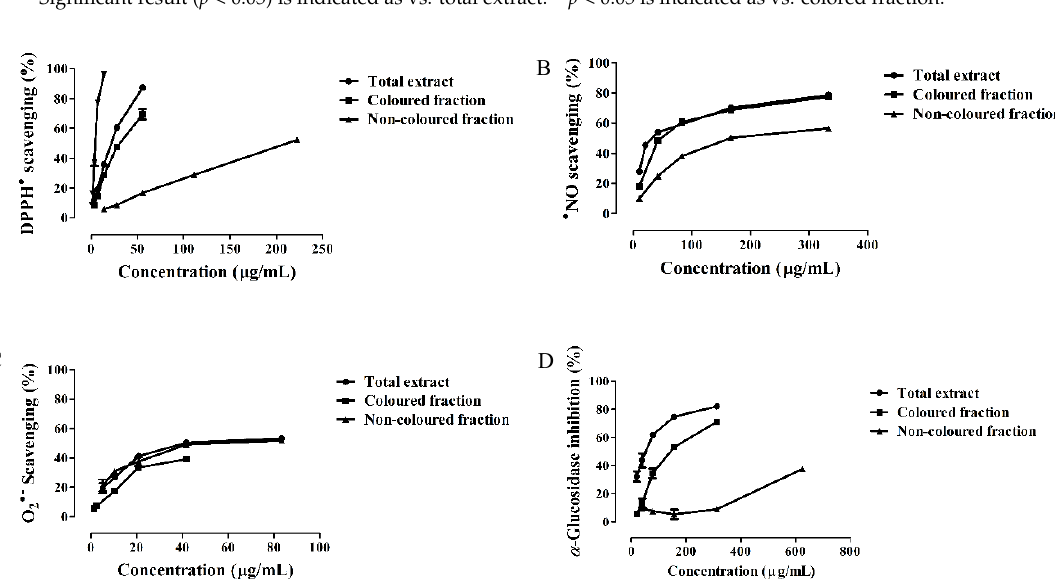
Figure 1. Antioxidant activity against ( A ) 1,1-diphenyl-2-picrylhydrazyl radical (DPPH • ), ( B ) nitric